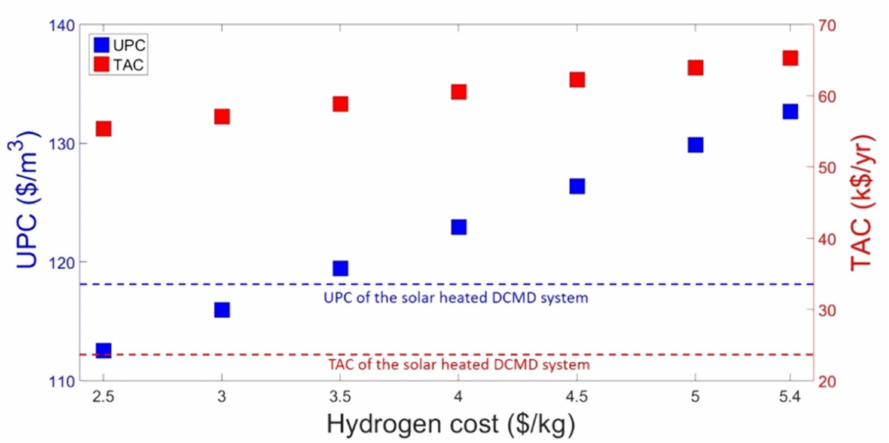
Figure 13. The relationship of the hydrogen price to the UPC and the TAC of the PEMFC coupled solar-heated membrane distillation